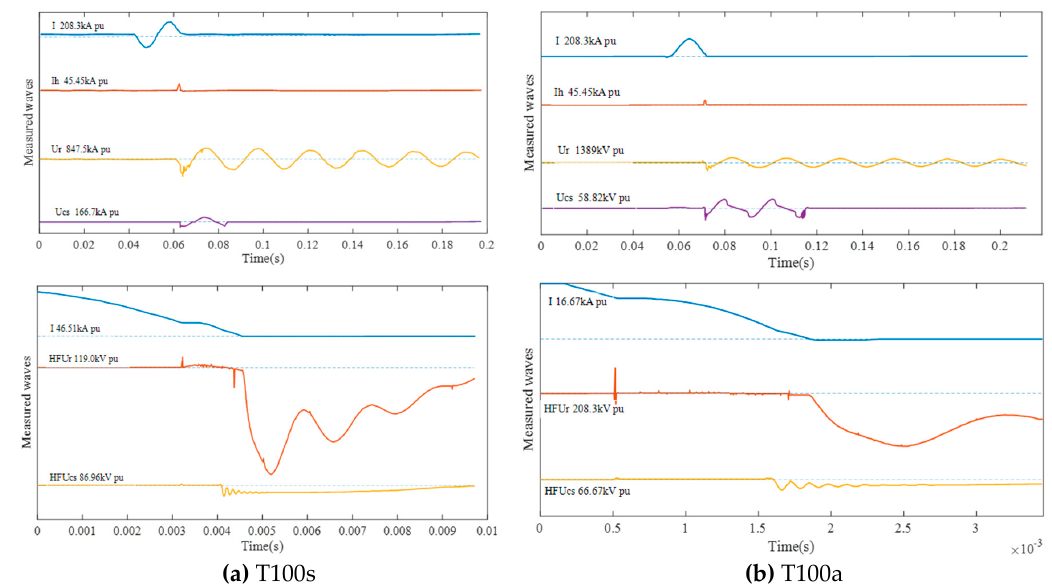
Figure 9. Test waveforms of the synthetic breaking test at 63 kA.